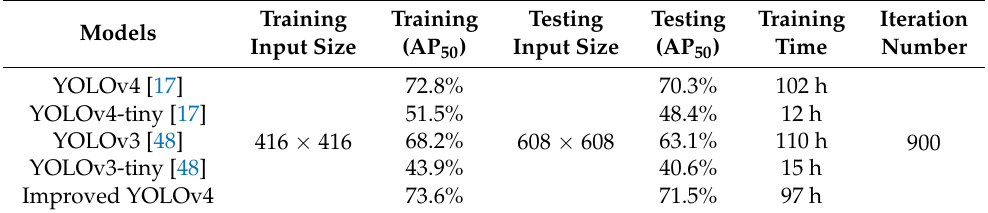
Table 5. Accuracy performance with augmented dataset (30,000 images).